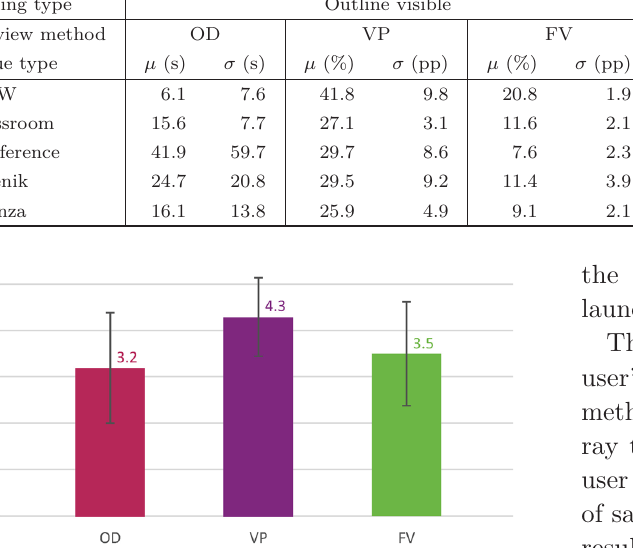
Fig. 6 Arithmetic means and the standard deviations of the amount of artifacts the participants saw when looking around. These numbers were measured after the users were satisfied with the rendering of their point of